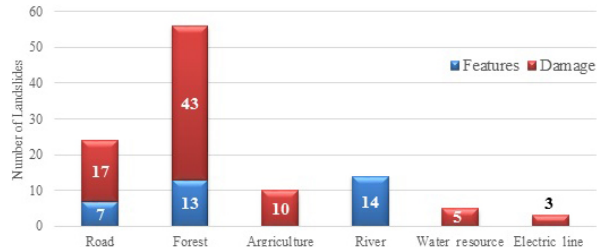
Figure 14. Relationship between features and landslides damage: for example 56 landslides occurred in forest and, of these, 43 dam- aged the forest (red: